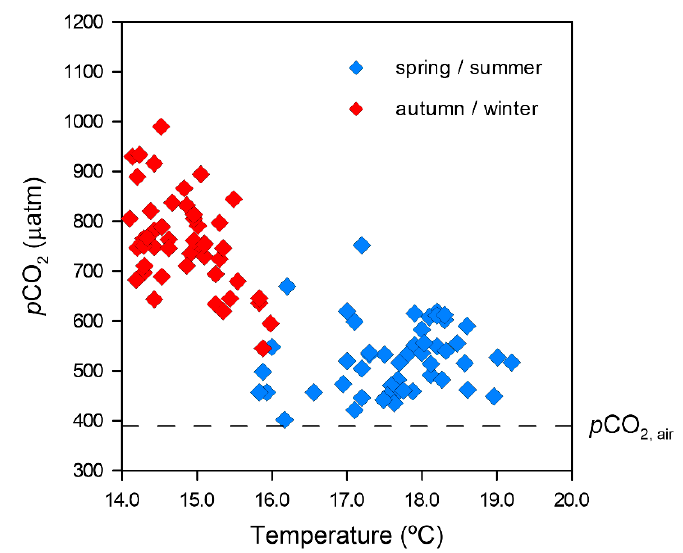
Figure 6. Distribution of CO 2 partial pressure ( p CO 2 ) as a function of surface temperature for all sampling periods in the Tagus fixed station. The dashed horizontal line represents the mean atmospheric CO 2 pressure ( p CO 2, air = 389.2 µatm) for the year 2007.